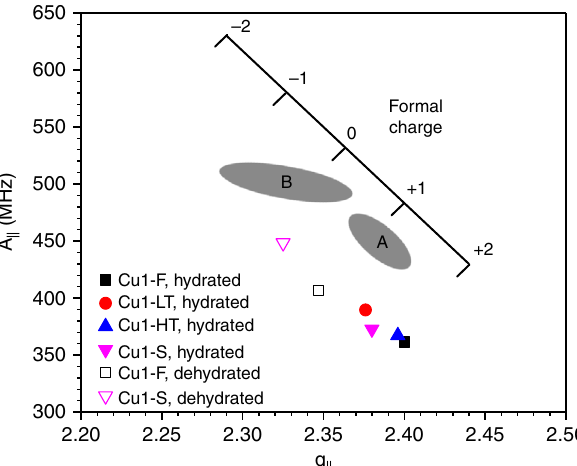
Fig. 2 Correlations between (g || , a || ) tensor pairs and formal charges of Cu (II) ions in the Cu1 samples. Note that shaded areas “ A ” and “ B ” represent typical (g || , A || ) pair positions found in hydrated and dehydrated Cu/zeolite materials, respectively